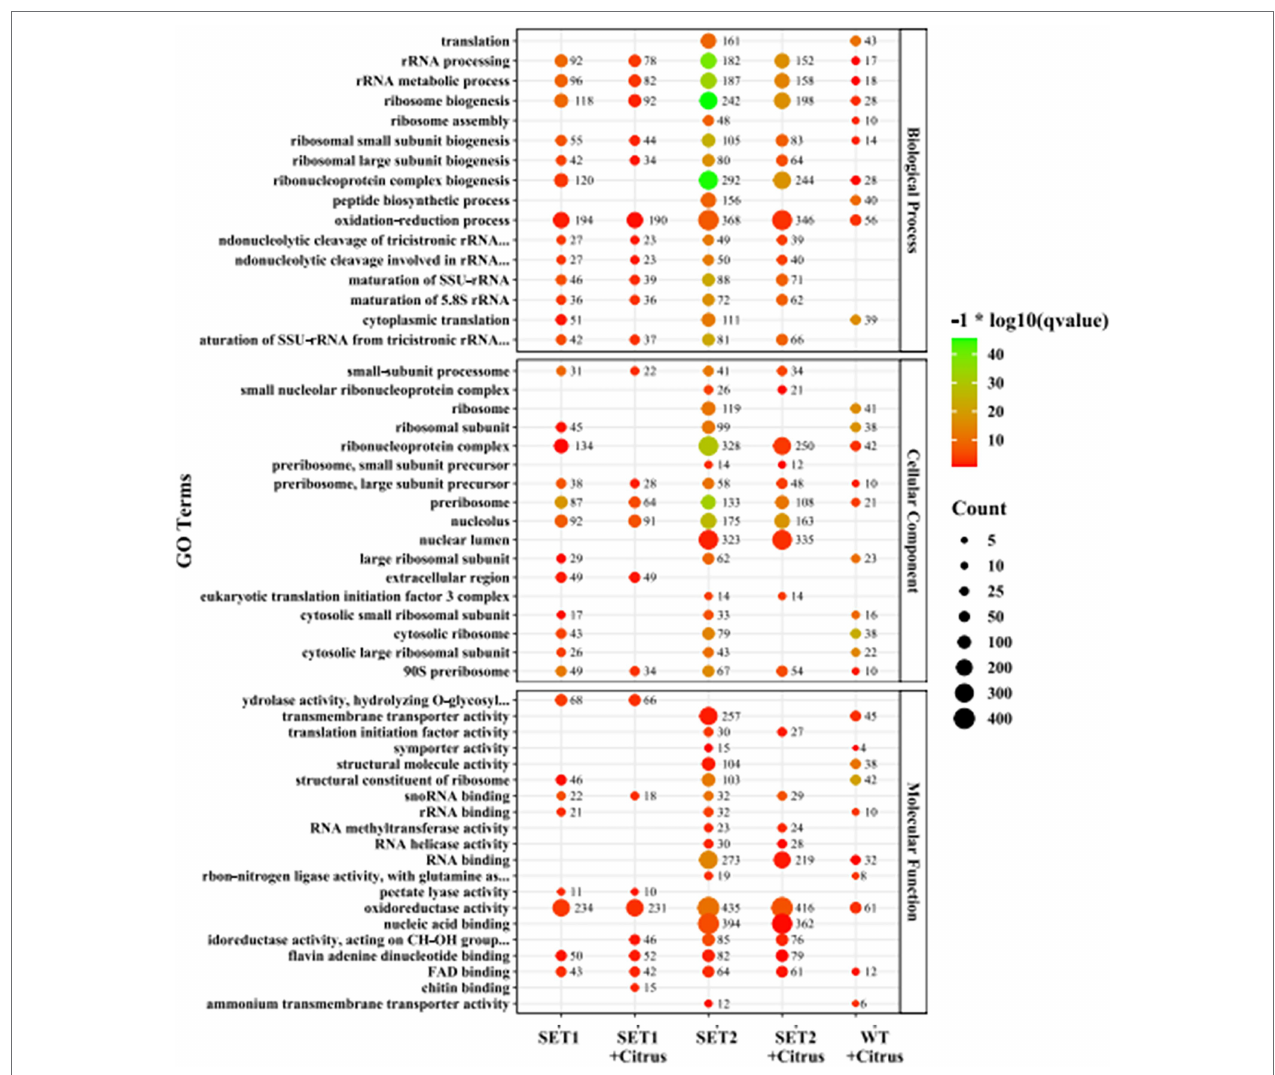
FIGURE 7 | GO enrichment analysis of Δ AaSet1 and Δ